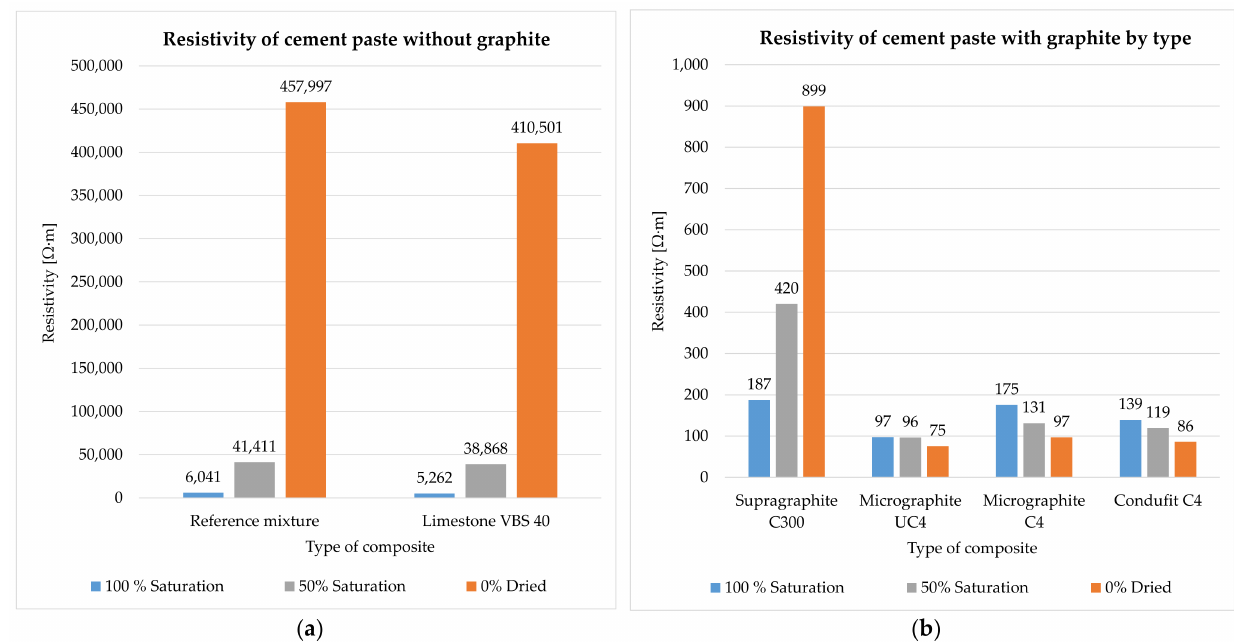
Figure 10. Comparison of resistivity in cement pastes at 100%, 50% and 0% water saturation, samples: ( a ) without the content of graphite; ( b ) with the content of graphite.